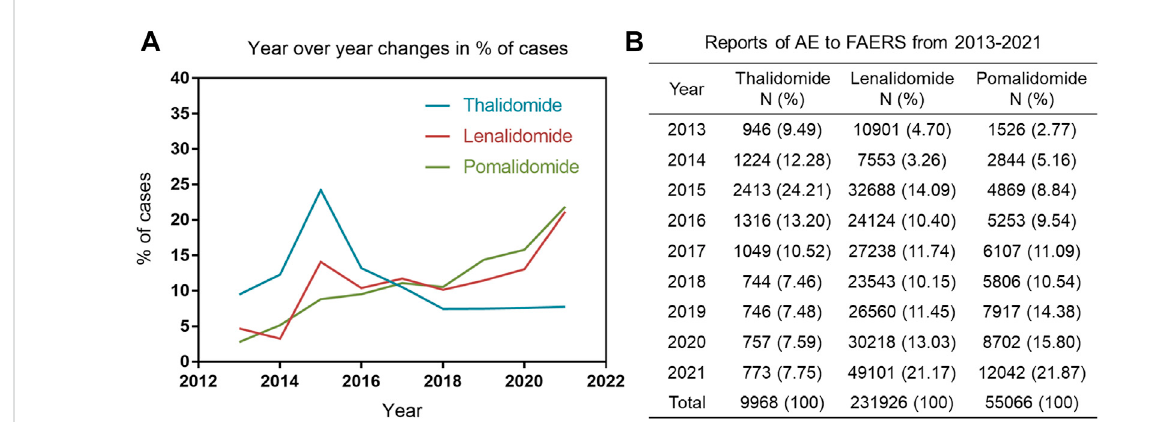
FIGURE 2 (A) Line graph with the percentage of AE reports of immunomodulatory drugs (IMiDs) published per year. (B) The number and percentage of cases reported to the food and drug administration adverse event reporting system caused by